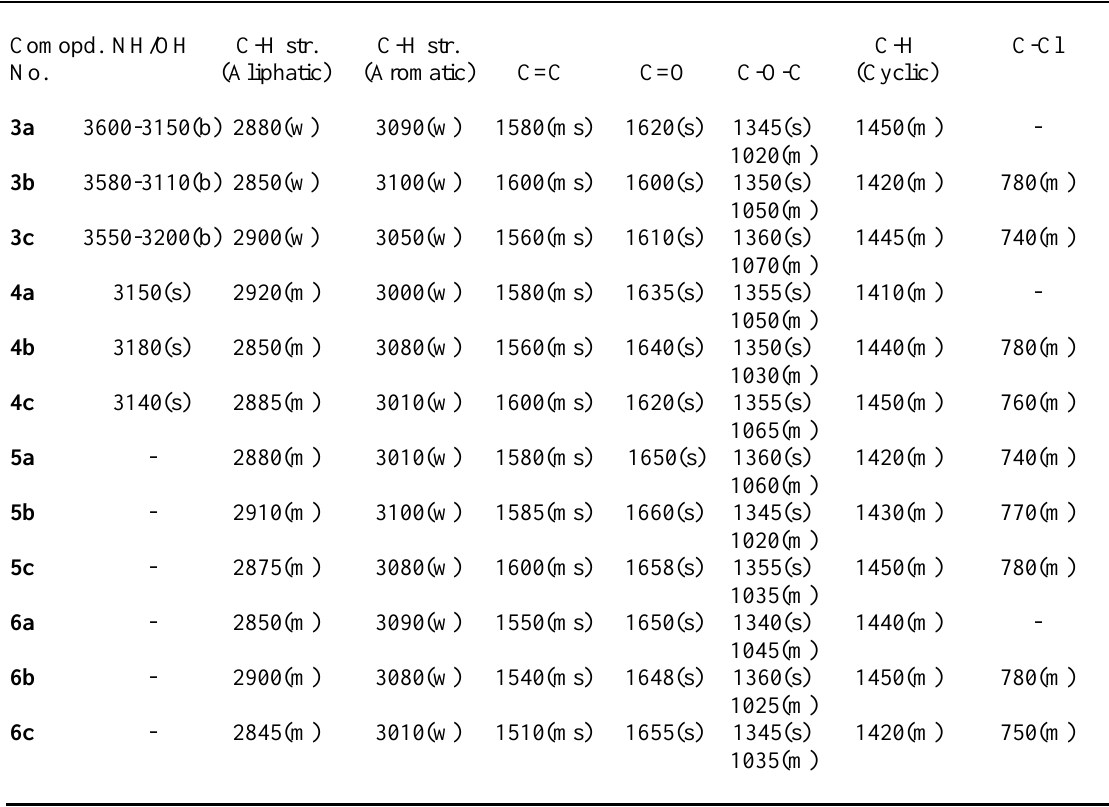
Table 2. The IR spectral data of 1,5-benzothiazepine derivatives.